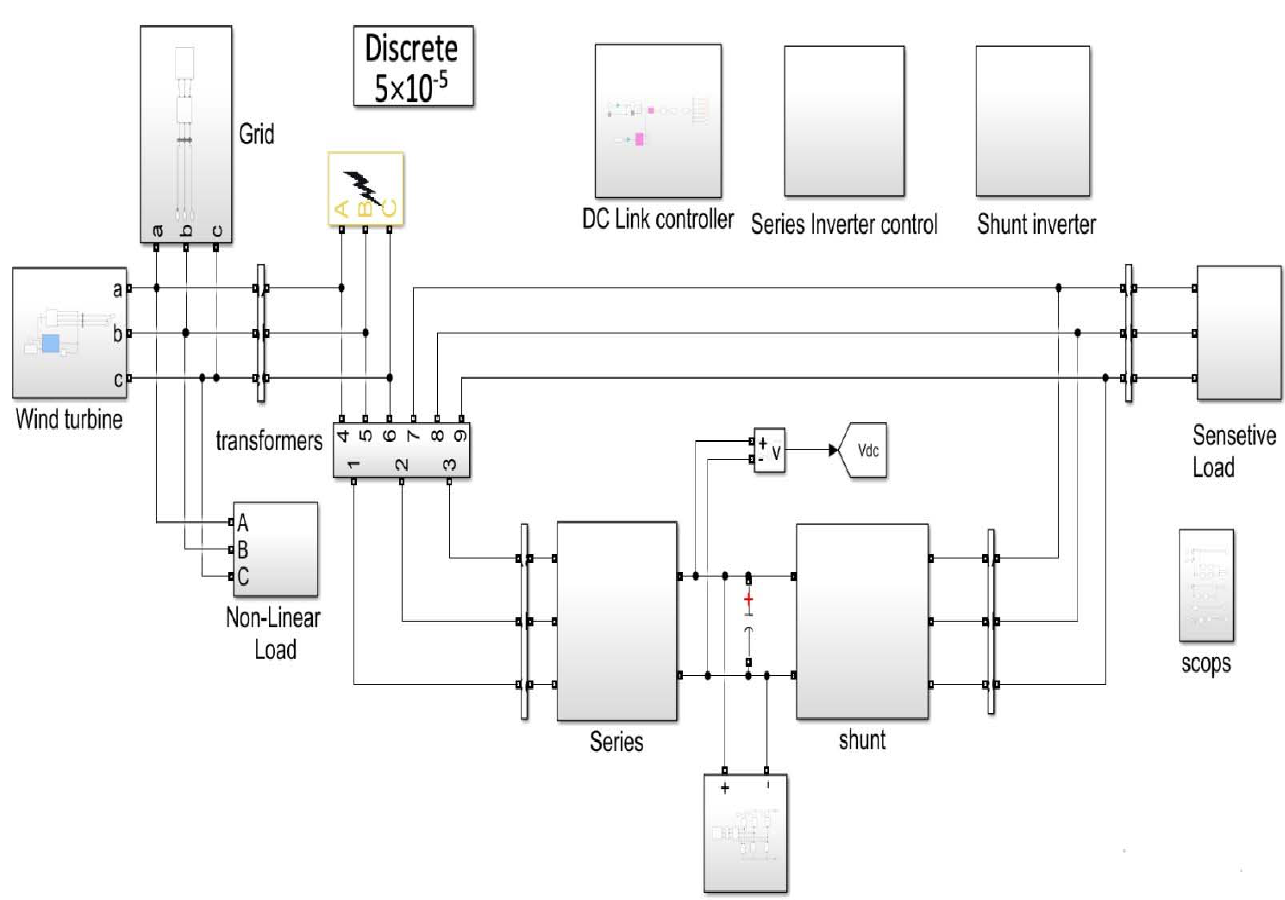
Figure 11. The full simulation for the system (non-linear load on the grid side).